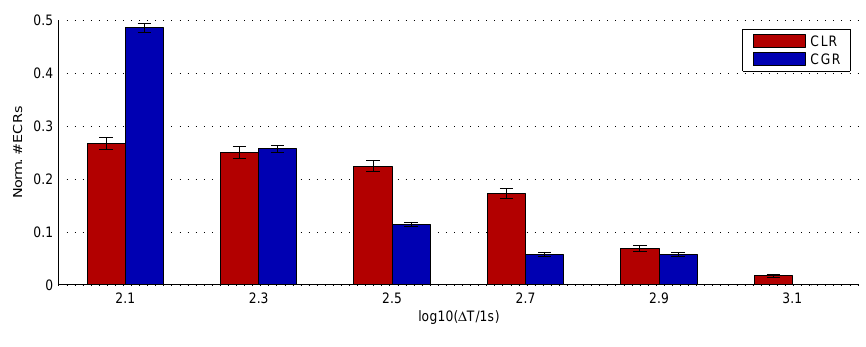
Fig. 2. Time extent of ECRs. Red and blue correspond to CLRs and CGRs, respectively. The error bars indicate the influence from the limited statistics (no instrumental errors are included). The data are normalized so that all red bars sum up to one and the same for the blue bars. We see that shorter CLRs and CGRs are more common. The cut-off at 1T = 100s is caused by the selection criteria of the automatic